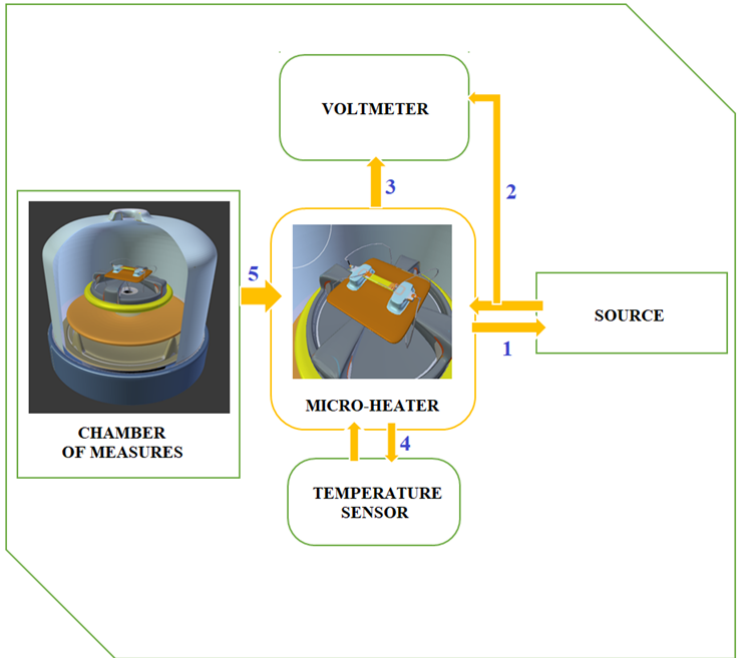
Figure 4. Microheater measuring